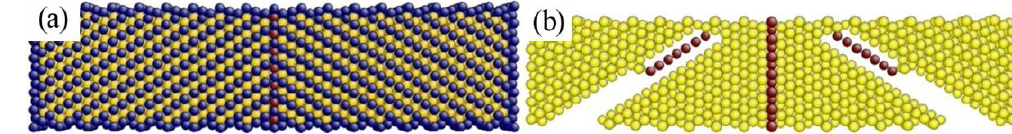
Figure 7. Atomic configuration of the simulation cell at ( a ) point A and ( b ) point B in Figure 6c. The atoms with unspecific coordination are deleted in ( b ) for a clear view of dislocation.